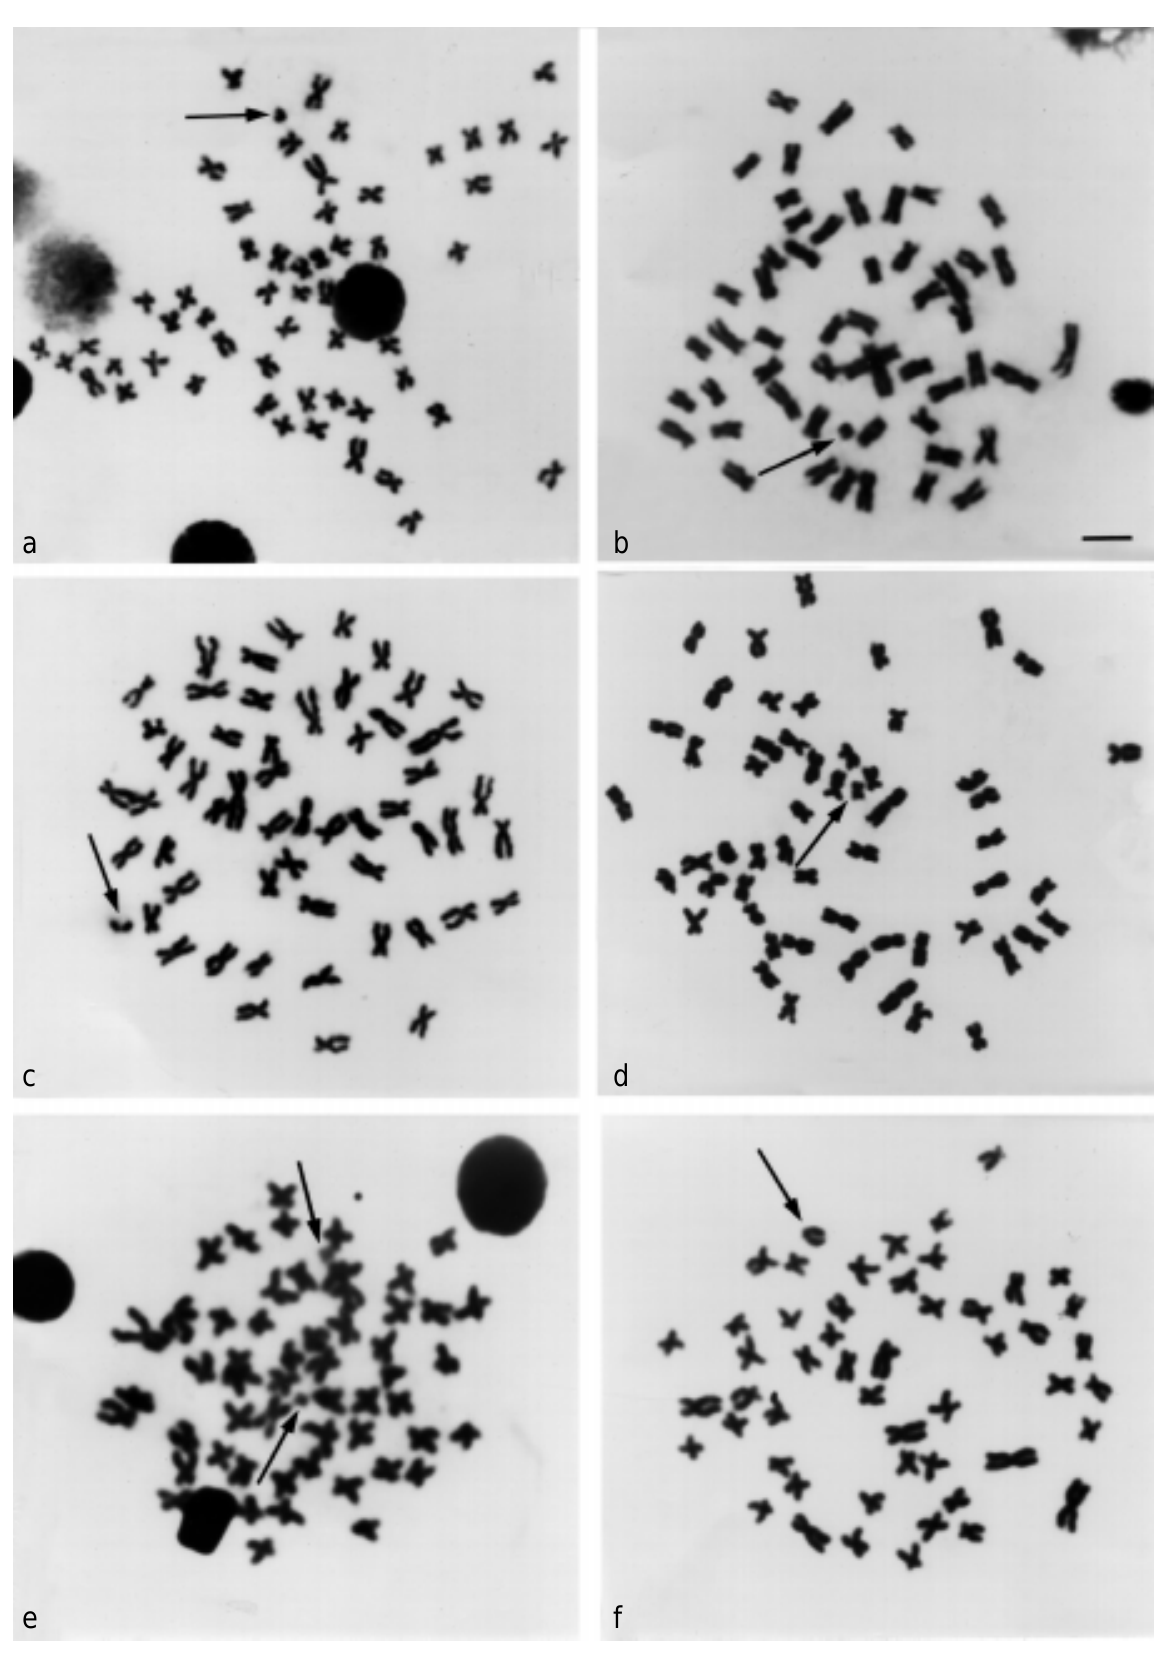
e Figure 1 - Giemsa-stained metaphases of (a) Leporinus friderici from the Candeias River, (b) Leporinus friderici from the Araguaia River, (c) Leporinus sp., (d) Cyphocharax modesta , (e) Prochilodus nigricans and (f) Characidium cf. zebra . The arrows indicate the supernumerary chromosomes. Bar = 5 µm.